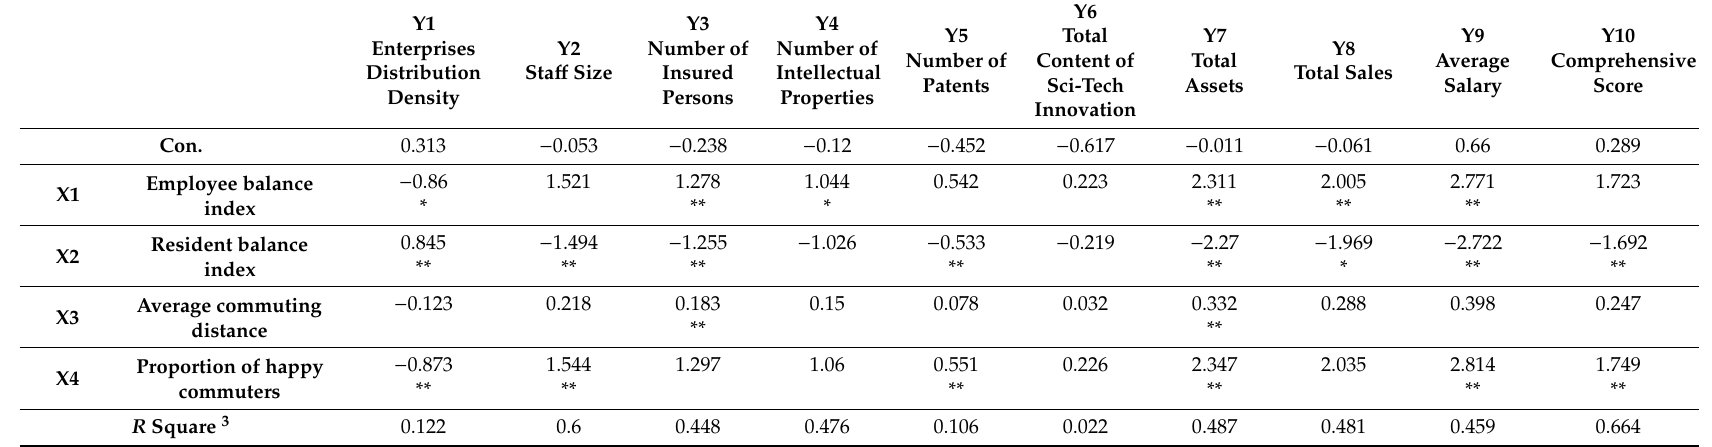
Table 5. Regression coe ffi cients 1 and p -value 2 of the partial least squares regression